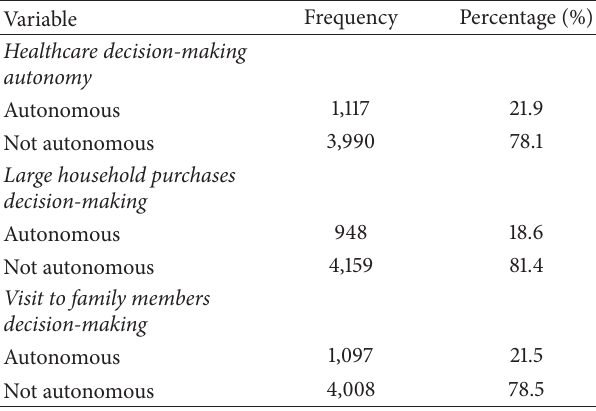
Table 2: Empowerment status by category, Ghana DHS